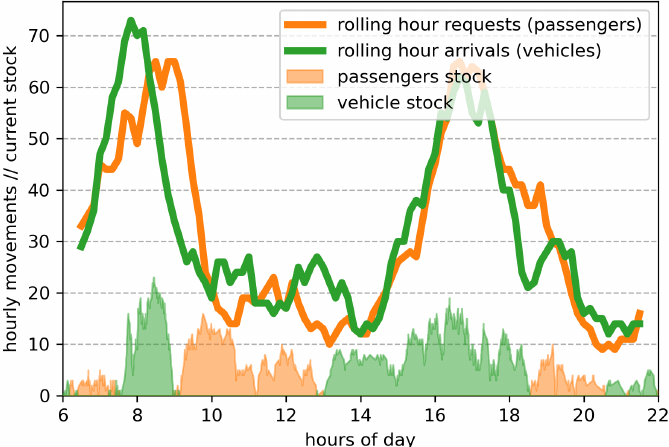
Figure 8. Illustration of vehicle and passenger stock resulting from imbalances in arrivals and